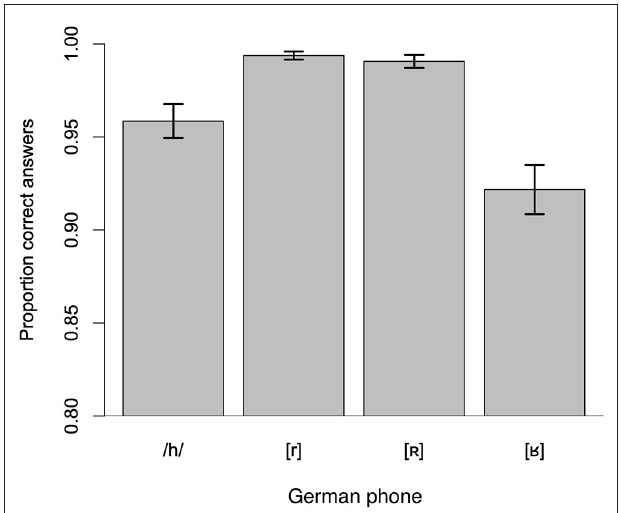
FIGURE 1 | Results of the identification task for German /h/ and the three allophones of /r/. Error bars represent 1 standard error were adjusted for the within-participant manipulation of Phone (see Morey, 2008). Note that means and standard errors were calculated in logistic space and transformed back to the proportion scale for plotting.